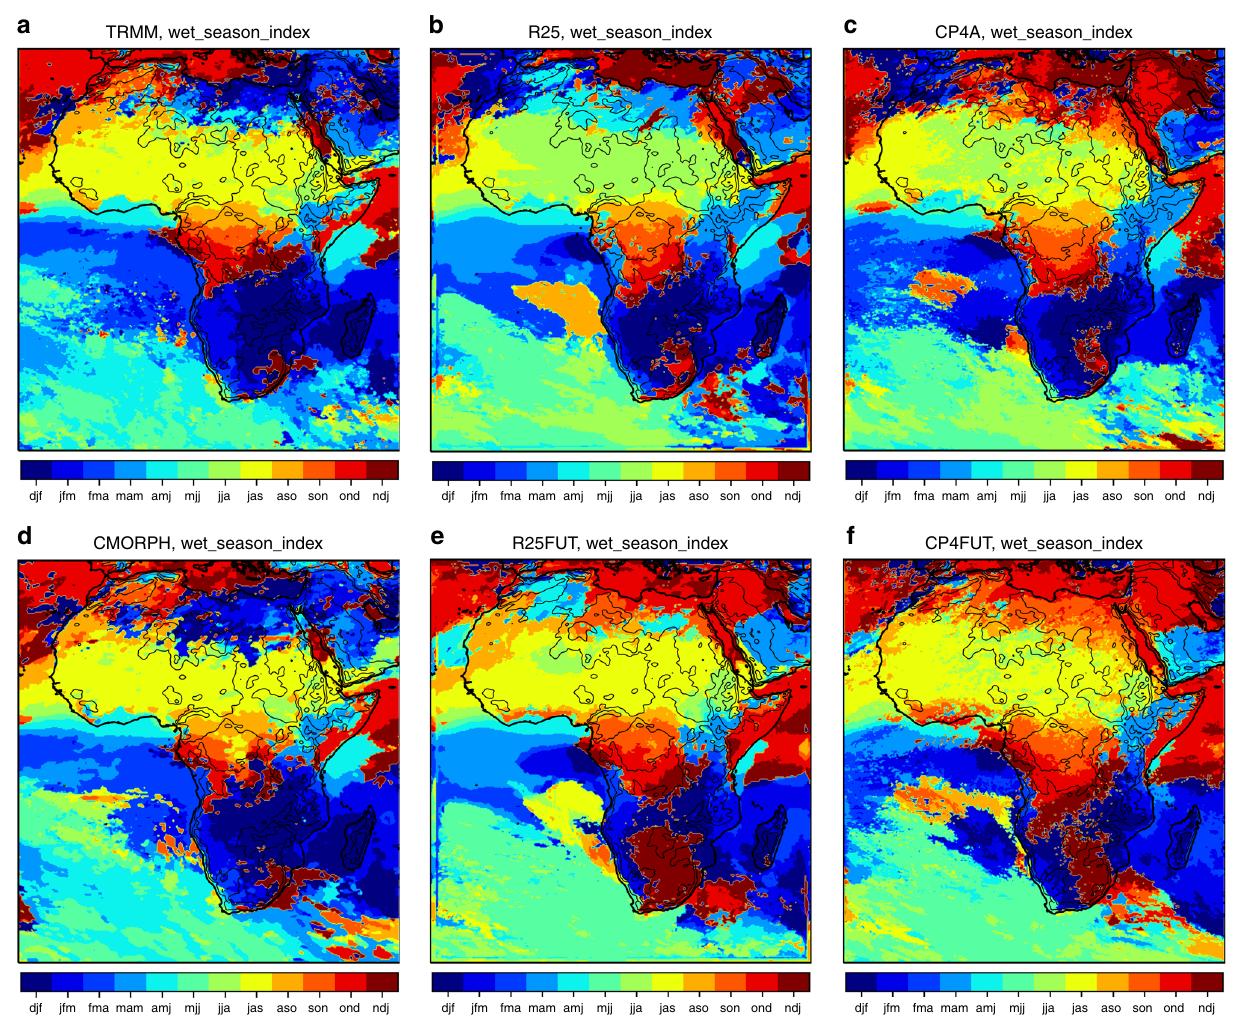
Fig. 1 Wet season index. Three-month period with the highest mean precipitation in a , d TRMM, CMORPH and b , e R25 model, for present day and future, and c , f CP4A, for present day and future. The black lines indicate the 500 -, 1000-, 2000-, 3000- and 4000 -m height contours. For Figs. 2 – 6, 10 and Supplementary Figures 11 – 16, wet season as observed in TRMM is used as a common de fi nition for all